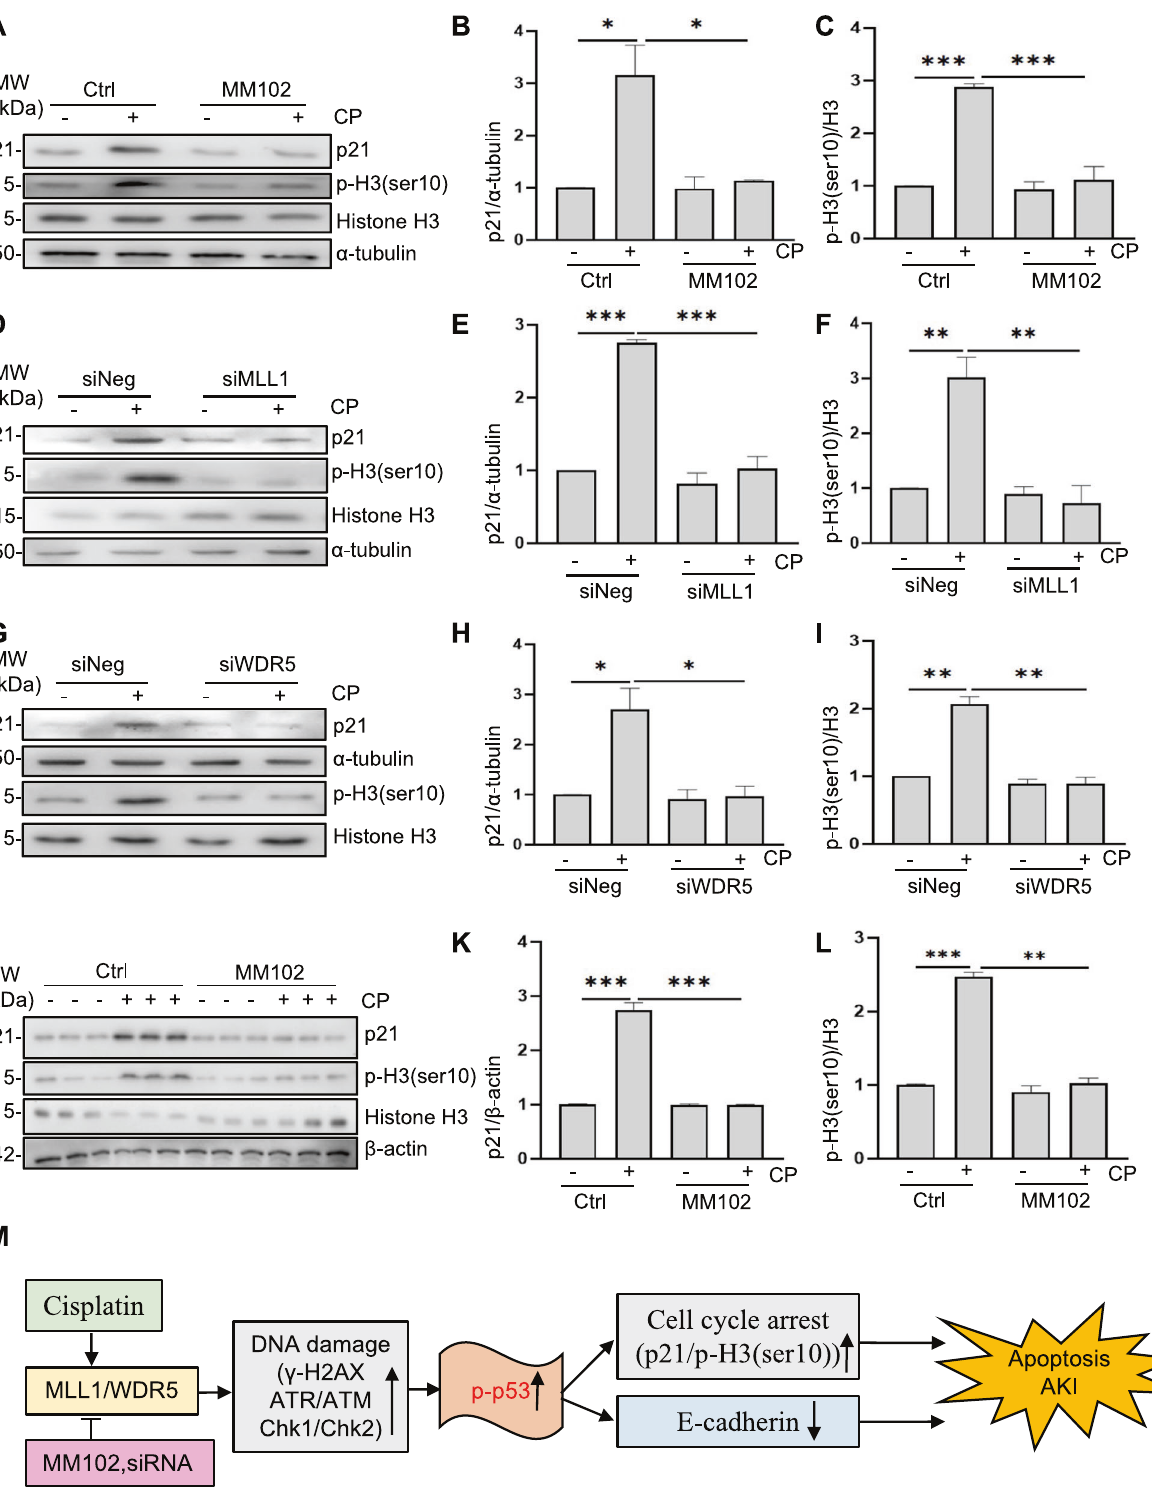
Fig. 8 Blocking MLL1/ WDR5 inhibits cisplatin (CP)-induced cell cycle arrest in kidney of mice and in cultured murine renal proximal tubular epithelial cells (RPTCs). RPTCs were treated with MM102 (50 μ M) or transfected with siRNA targeting MLL1 or WDR5 and then exposed to CP (20 μ M) for an additional 24 h. Mice were intraperitoneally injected with MM102 (15 mg/kg) 2 h before CP (20 mg/kg) injection, and then given daily for three consecutive days. All the mice were euthanized 72 h after CP injection. The bands presented show Western blotting results for p21, phosphor-histone H3 on serine 10 (p-H3 (ser10)), histone H3 and references in vitro ( A , D , G ) and in vivo ( J ). B , C , E , F , H , I , K , L The graphs show p21 levels normalized to α -tubulin or β -actin, and p-H3 (ser10) normalized to H3. Values are mean ± SD. A representative result from at least three experiments was shown. * P < 0.05, ** P < 0.01, *** P < 0.001. M Schematic diagram for the role of MLL1/ WDR5 in CP-induced renal tubular cell apoptosis and acute kidney injury (AKI).